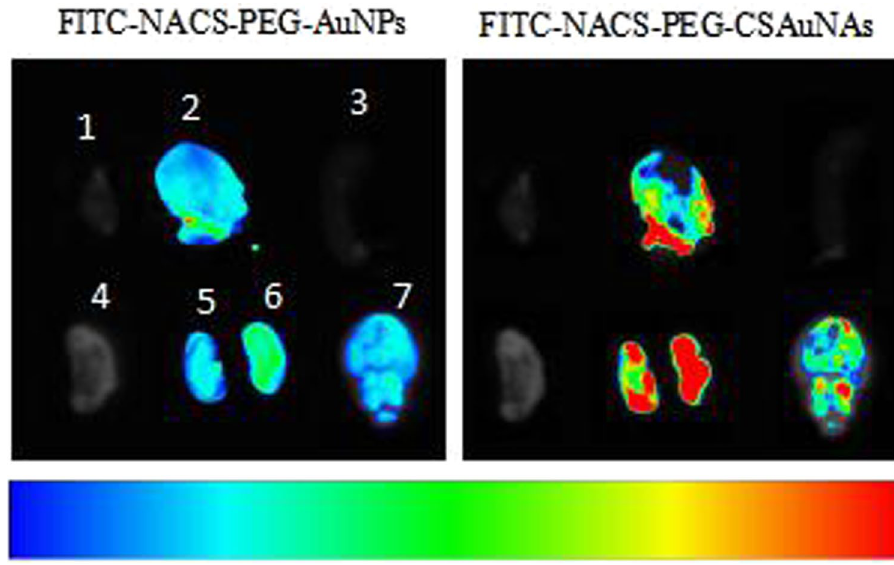
Figure 8. Fluorescence imaging of FITC-NACS-PEG-CSAuNAs and FITC-NACS-PEG-AuNPs in vivo (1, heart; 2, liver; 3, spleen; 4, lung; 5, left kidney; 6, right kidney; 7,